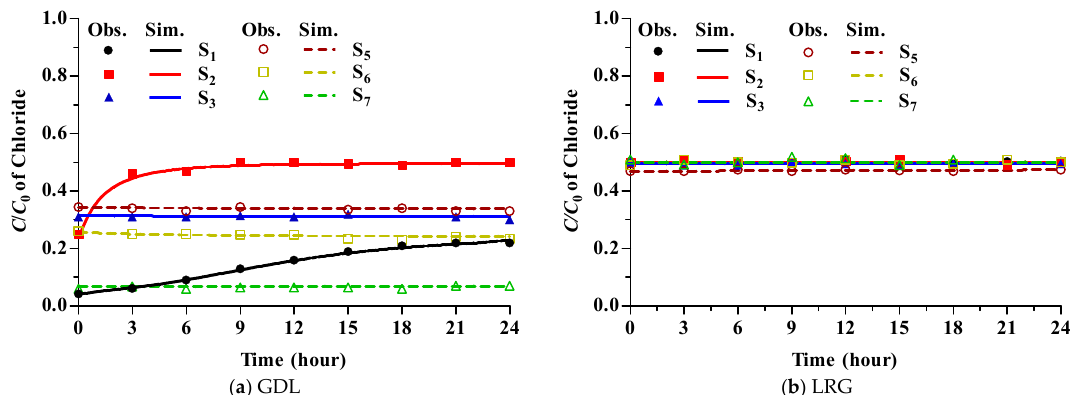
Figure 6. Simulated and observed chloride concentrations near the lake–groundwater interface during a one-day period after wind waves started in the GDL ( a ) and LRG ( b ) cases. (lines: simulated by Hydrus-2D; symbols: observed during the soil flume experiments). C 0 : the input chloride concentration from the fishpond/paddyfield.